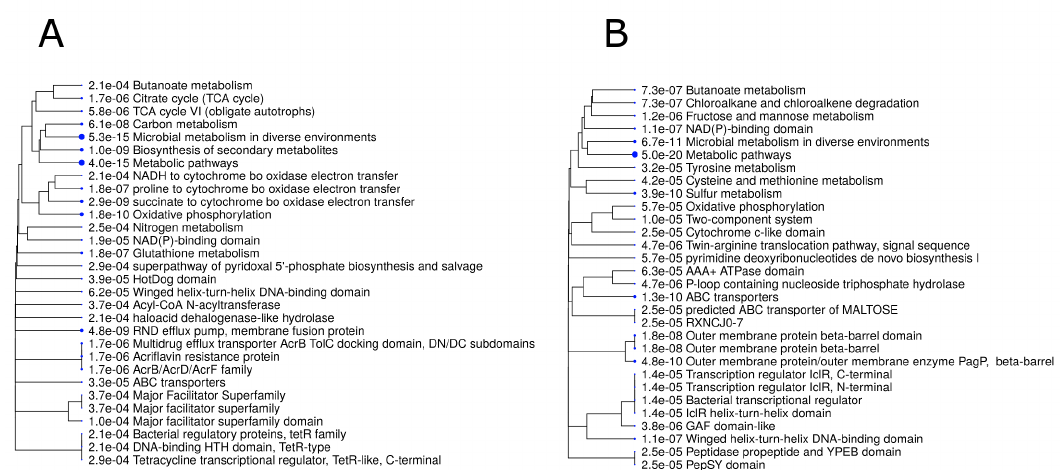
Figure 2. A hierarchical clustering tree, summarizing the correlations between significant pathways among the list of upregulated ( A ) and downregulated ( B ) genes. Pathways with many shared genes are clustered together. Larger dots indicate more significant p